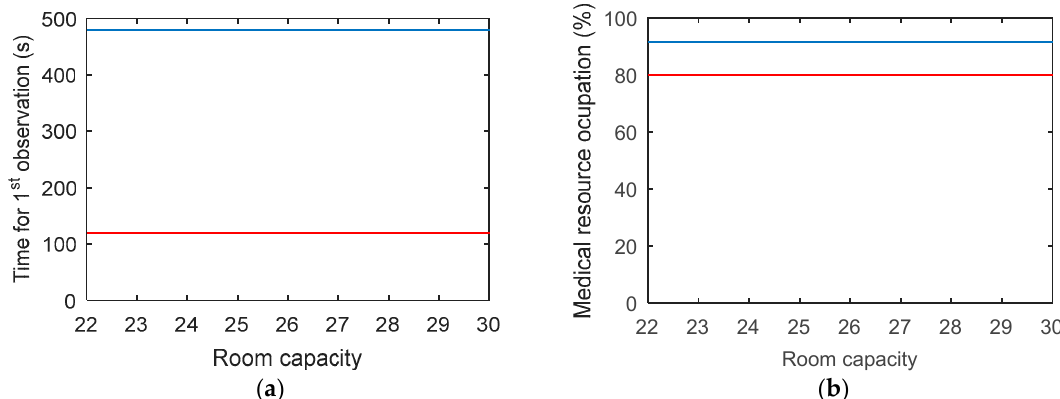
Figure 12. Obtained values for different capacity scenario: ( a ) waiting time for first medical intervention (blue line — simulation model, red line — Manchester time); ( b ) medical resource occupation (blue line — simulation model, red line — occupation rate limit).